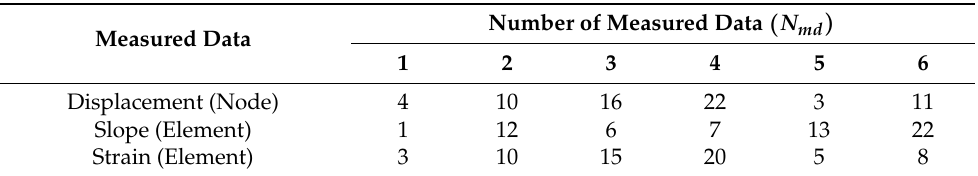
Table 3. Sensor location in the FEM model used for estimation (truss).